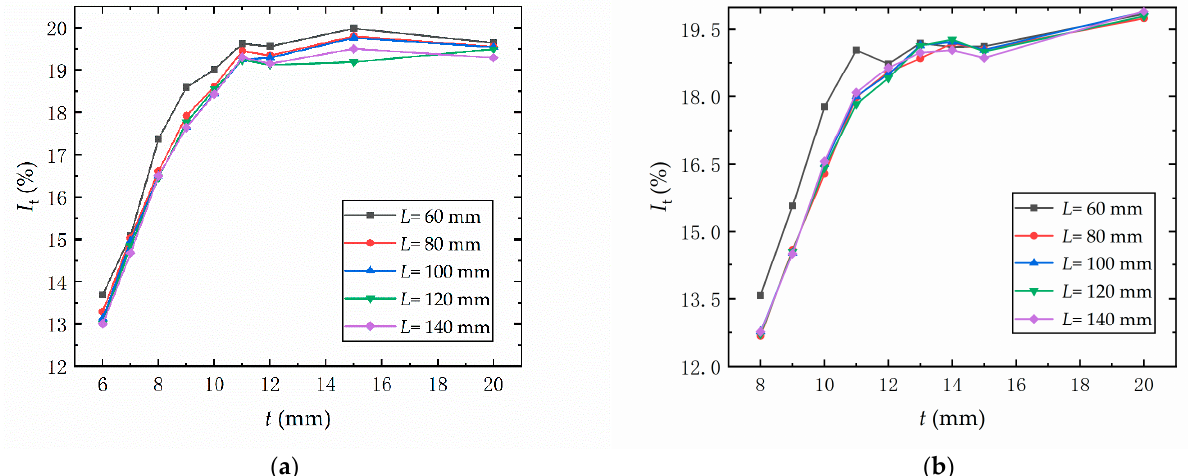
Figure 12. Influence of hollow section parameters on I t : ( a ) hollow mandrel scheme 1; ( b ) hollow mandrel scheme 2.